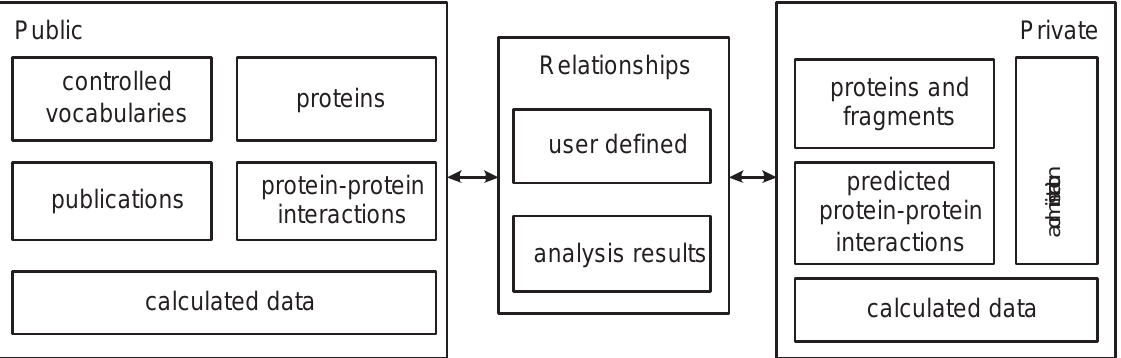
Figure 1: Core database areas of ISP